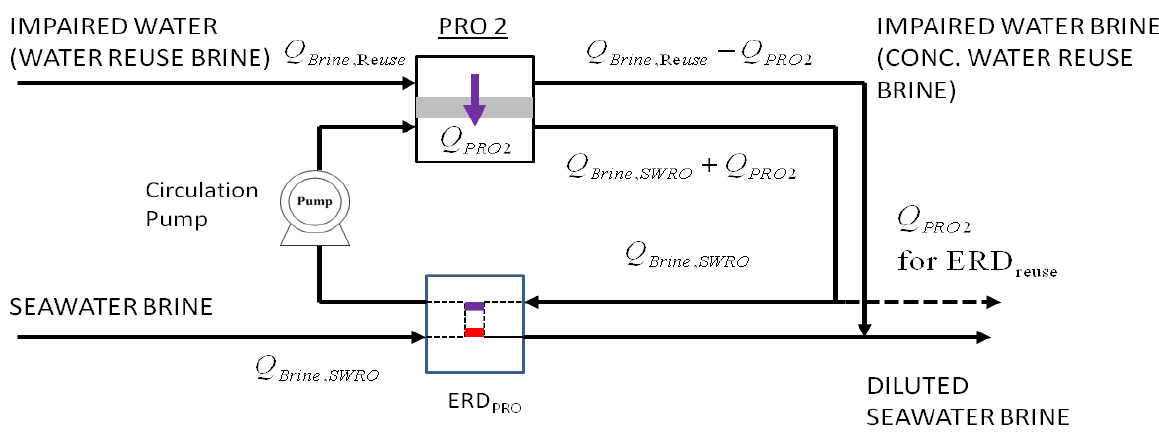
Figure 4. PRO process of high efficiency, adapted from